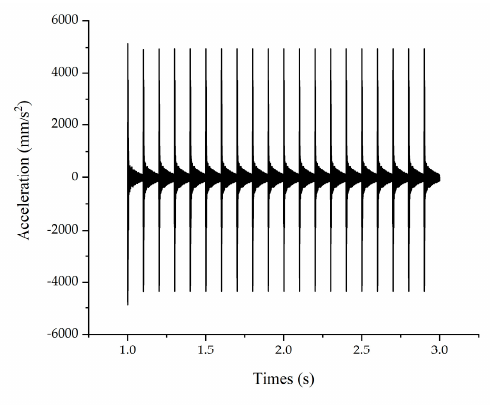
Figure 12. Constant-amplitude continuous impulse excitation acceleration response.